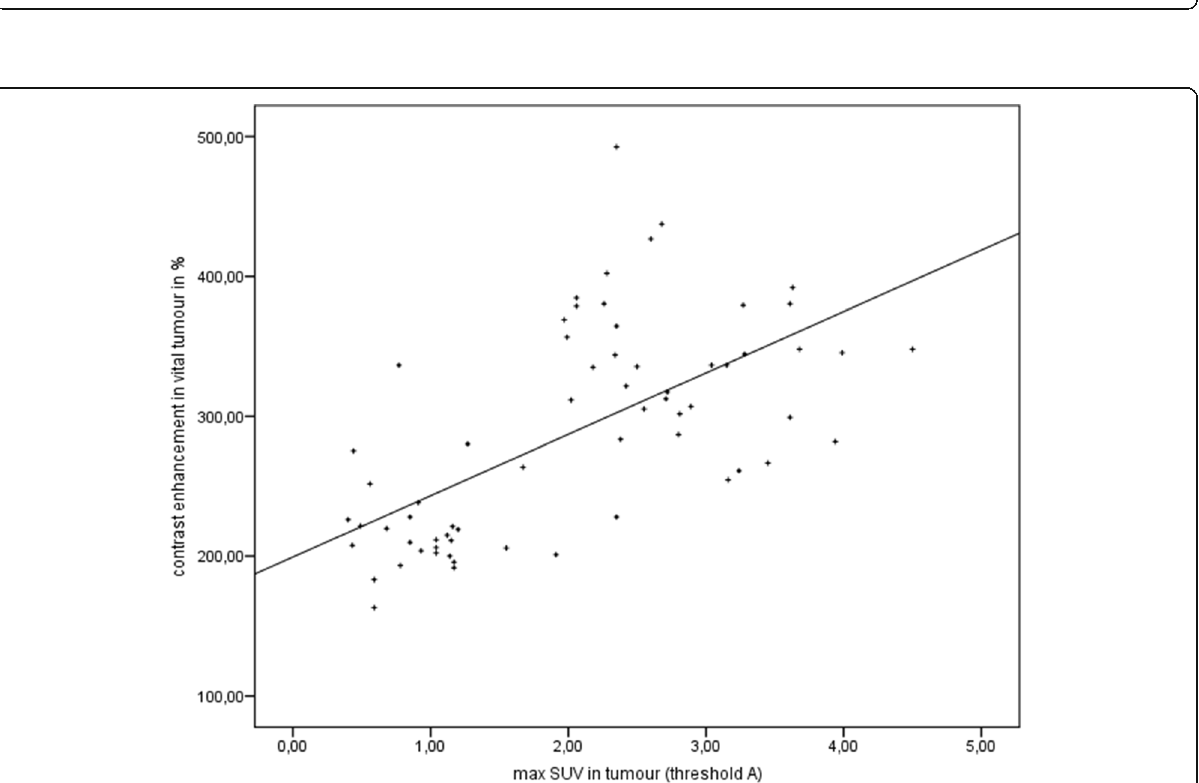
Fig. 11 Correlation. Spearman ’ s rank correlation between the maximal SUV in [18F]FDG-PET and the contrast enhancement in vital tumor in CE- CT; r = 0.635, p =